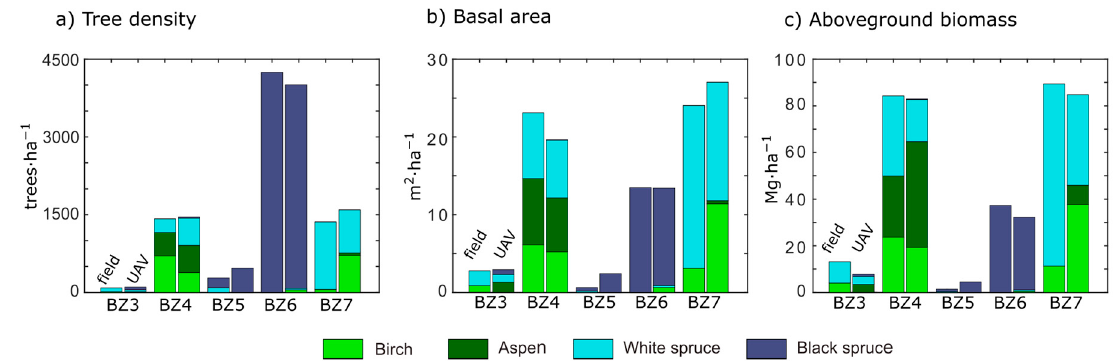
Figure 6. Proportional allocation of tree density (TD), basal area (BA), and aboveground biomass (AGB) by species for each FIA plot ( n = 5). Totals were estimated using the best-available method (see Figure 5). At each plot, field proportions are shown on the left and UAV proportions on the right.